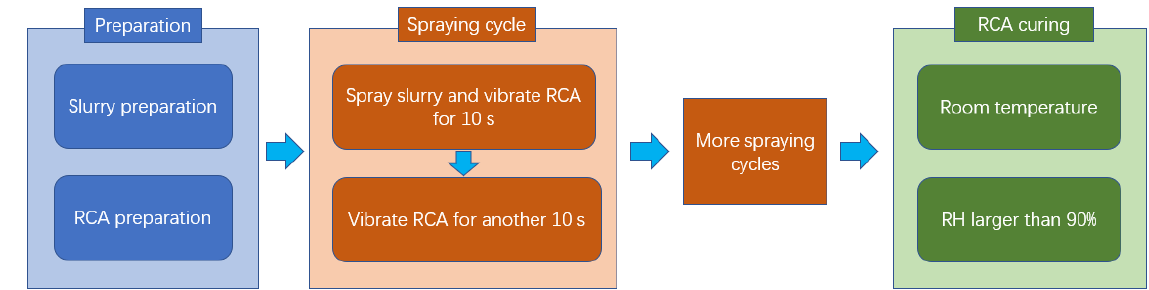
Figure 4. The procedure of the circular spraying treatment method.